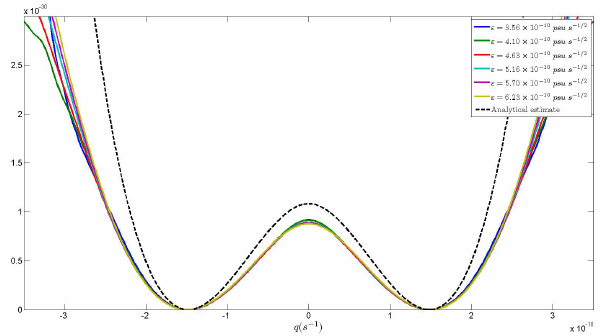
Fig. 6. Goodness of the one-dimensional approach for the non- symmetric case. (a) Average hopping rates r( + → − ) (blue line) and r( − → + ) (red line). Data are in units of s − 1 . (b) Geometrical factors G( + → − ) (blue line) and G( − → + ) (red line) computed from Eq. (7). Adimensional quantities. (c) Value of the parameter rγ giving the ratio between ε eff (obtained as a divided by b ) and √ the theoretically derived expression 2 kβε . Adimensional quanti- ties. The values obtained using the +→− (blue) and −→+ (red) processes are not